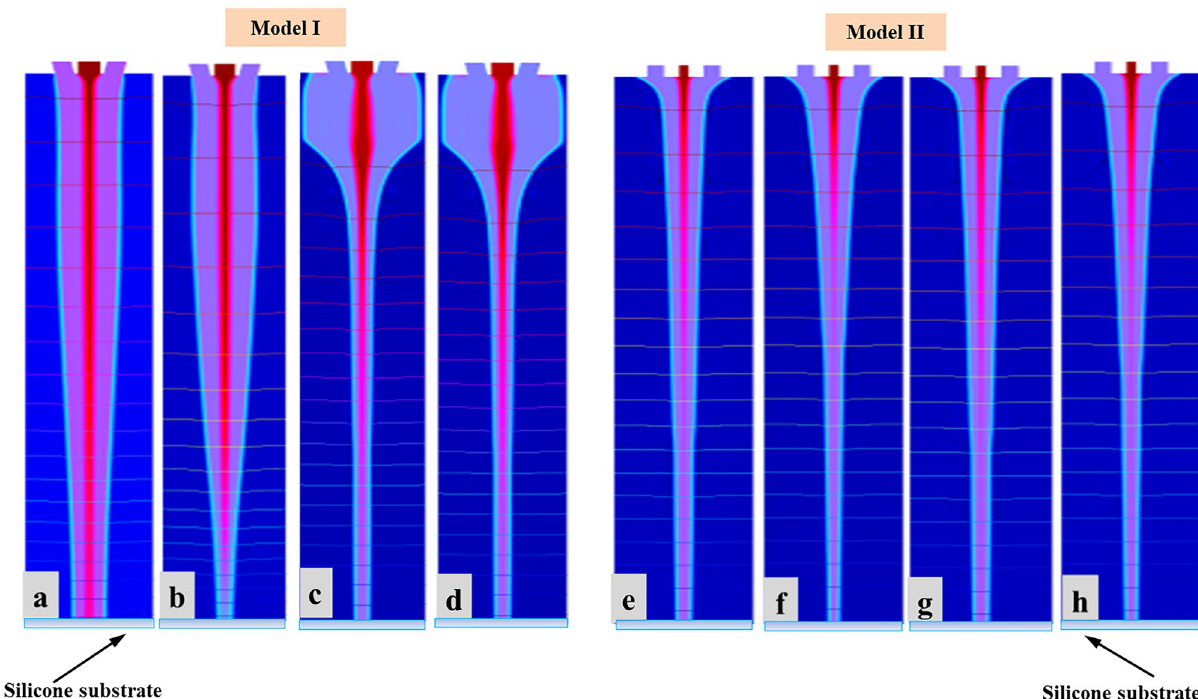
Figure 13. The different simulation results at different needle diameter and shape: Model (I) shows different simulation morphologies at different time intervals ( a – d ) by changing shape and size of outer needle: Model (II) shows different simulation morphologies at different time intervals ( e – h ) by changing size of inner